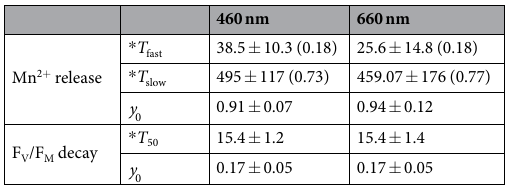
Table 1. T 50 values (min) for Mn 2 + release and loss of F V /F M during 1200 min light exposures. Each T 50 is presented ± standard error. Mn 2 + release was fitted to a biphasic curve and the T 50 for the slow and fast phase represents the offset used for the fitting ± standard error. are presented individually ± standard error. The y 0 Amplitudes are presented in parenthesis.